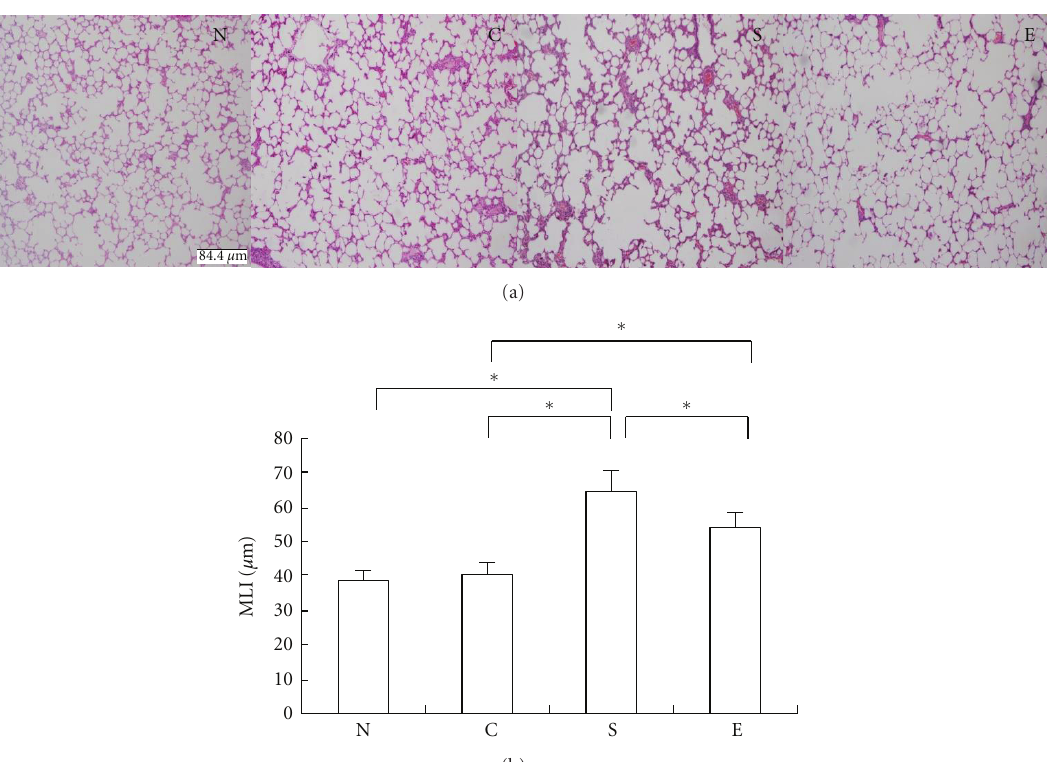
Figure 1: Treatment with erythromycin protects against the smoking-induced emphysema in rats. The lung tissue sections from di ff erent groups of rats were subjected to H&E staining, and the alveolar airspace enlargement was assessed using MLI by two independent individuals in a blinded manner. Data are representative images or expressed as mean value ± SD of each group of rats ( n = 10) from five separate experiments. (a) Morphological changes in the lungs of rats (magnification × 100). (b) Quantitative analysis of alveolar airspace. Group N: rats exposed to regular air without any special treatment; Group C: rats exposed to regular air and were treated with erythromycin; Group S: rats exposed to smoking air and were treated with saline; Group E: rats exposed to smoking air and were treated with erythromycin daily for nine weeks beginning at the forth weeks smoking. ∗ P < 0 .